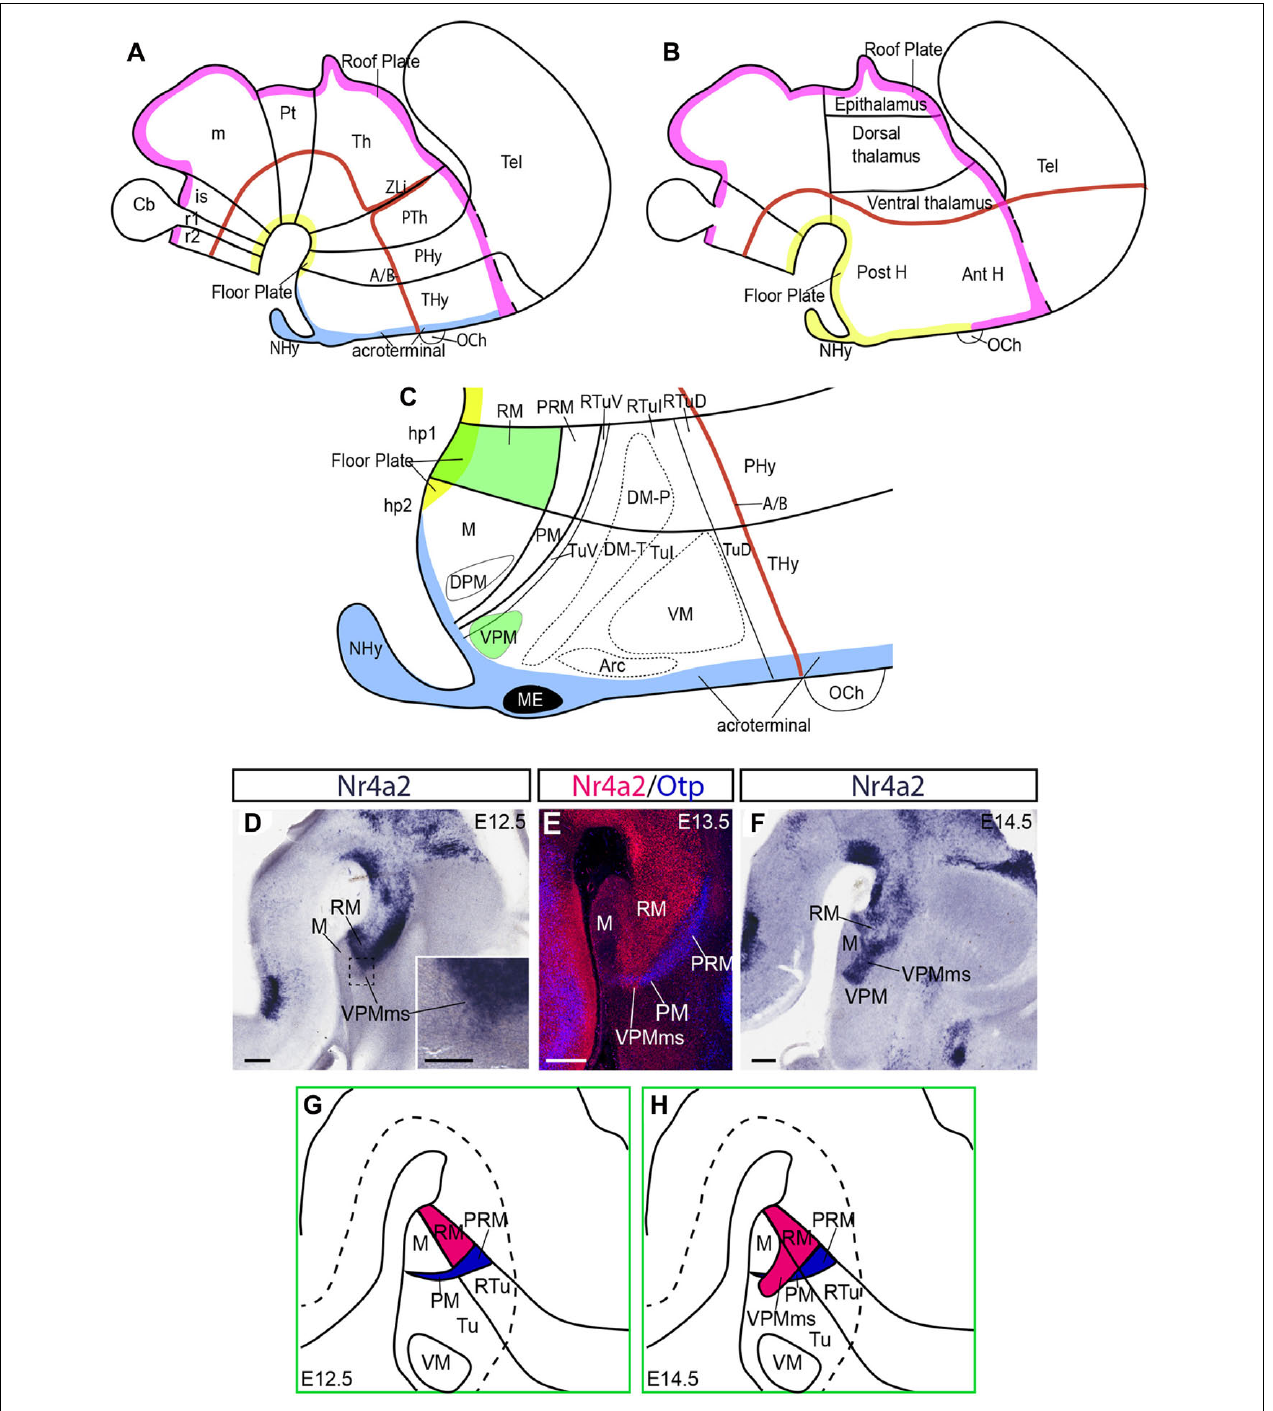
FIGURE 1 | Hypothalamus in the prosomeric model and a RM population invading hp2. (A,B) Sketches of the prosomeric and columnar models, emphasizing differences in the concept of the axis (red line, representing also alar-basal boundary) and longitudinal floor and roof zones (yellow and pink lines, respectively). Blue denotes the acroterminal domain, not distinguished in the columnar model. (C) More detailed schema of the basal hypothalamus in the prosomeric model, centered upon the postulated progenitor areas. The RM area and the migrated VPM nucleus are drawn in green. (D–H) Representative images and schemas of our preliminary molecular evidence and interpretive analysis of the VPM origin and migration out of RM; (D–F) three Nr4a2 -labeled sagittal sections of E12.5, E13.5, and E14.5 embryos showing progressive emergence of a positive cell group out of the RM area (VPMms), leading to the VPM. (D,F) In situ reaction. (E) This dark-field microphotograph shows two-color immunoreaction for Nr4a2 (red) and Otp, the latter identifying the PM/PRM band (blue; compare with C ). (G,H) Schemata of the emergence of the Nr4a2-positive rostrally migrating RM population relative to neighboring areas. Scale bars represent 200 µ m in (D–F) , and 100 µ m in (D) inset.